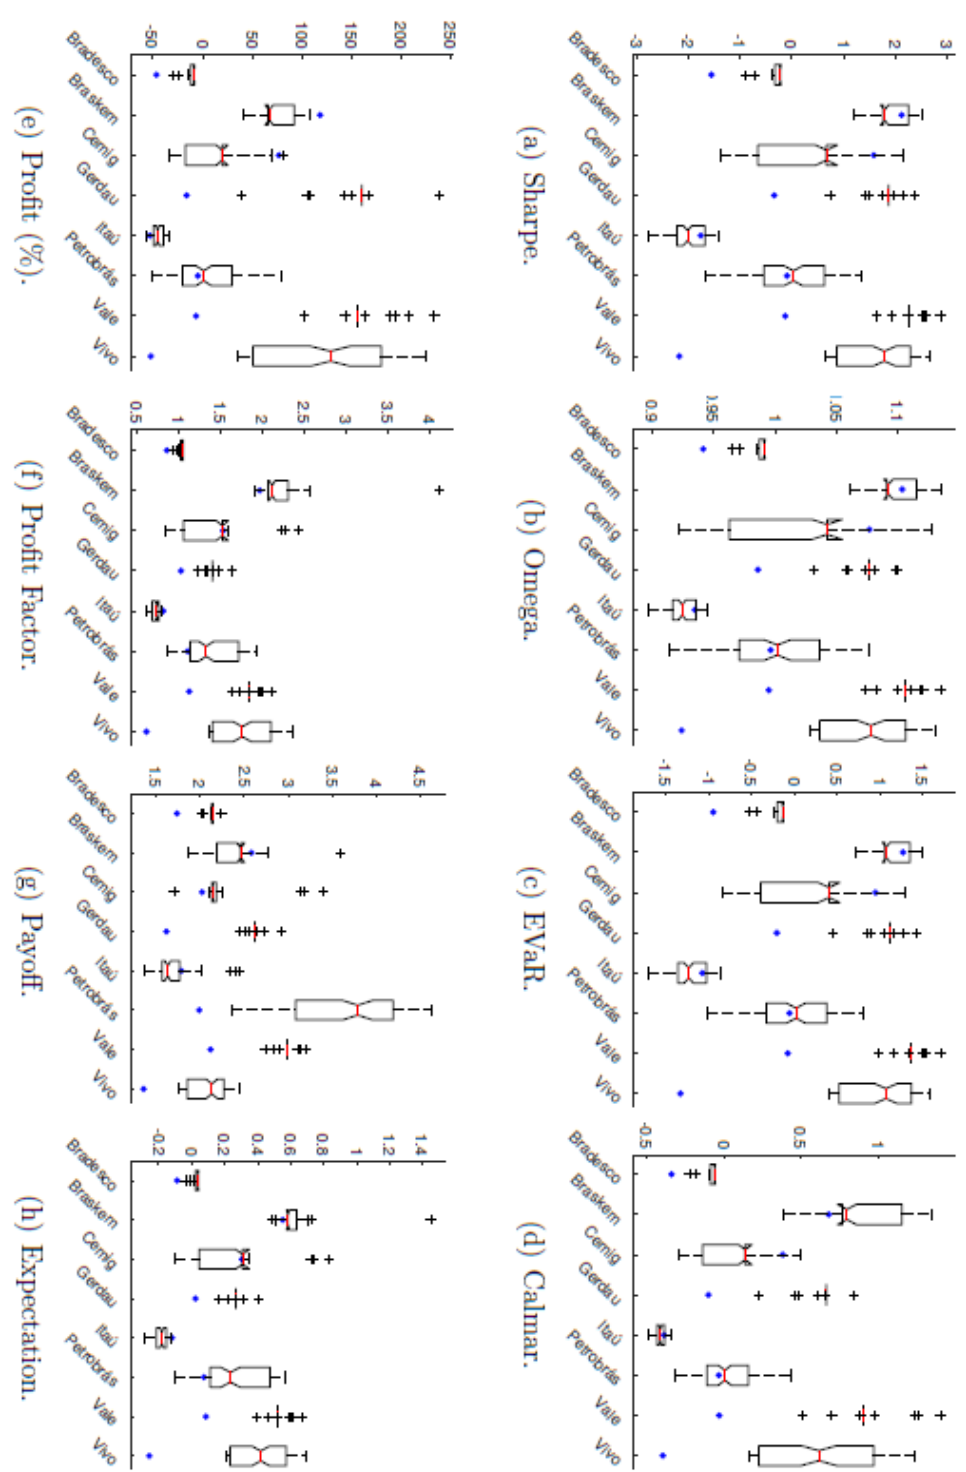
Figure 4. Distribution of results according to changes in the weighting factors. The blue cross indicates the ensemble outcomes.